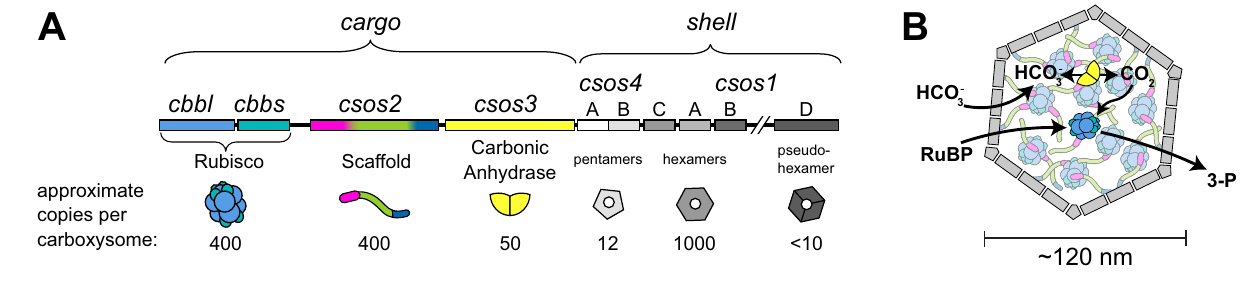
Fig.1|Schematicsofthe H.neapolitanus α -carboxysome.A The H.neapolitanus CB operon, with estimates of relative protein copy numbers per CB 11,17 . B Current working model of a carboxysome. Carbonic anhydrase converts bicarbonate